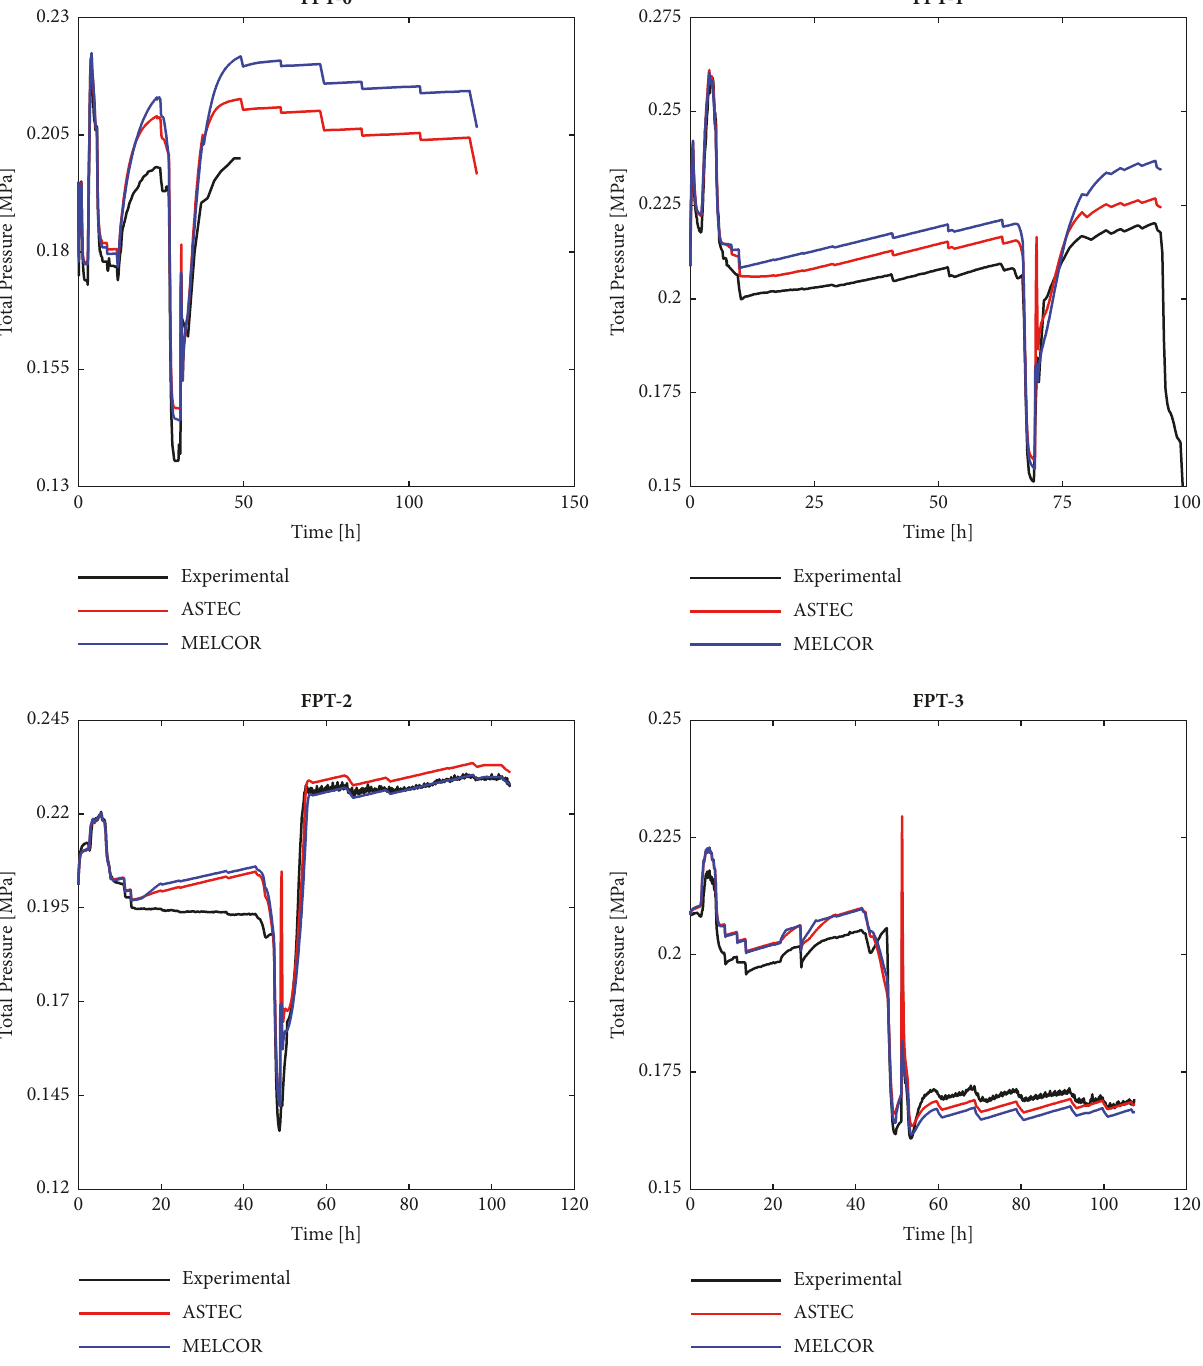
Figure 6: Total pressure evolution during the Ph´ebus FPT